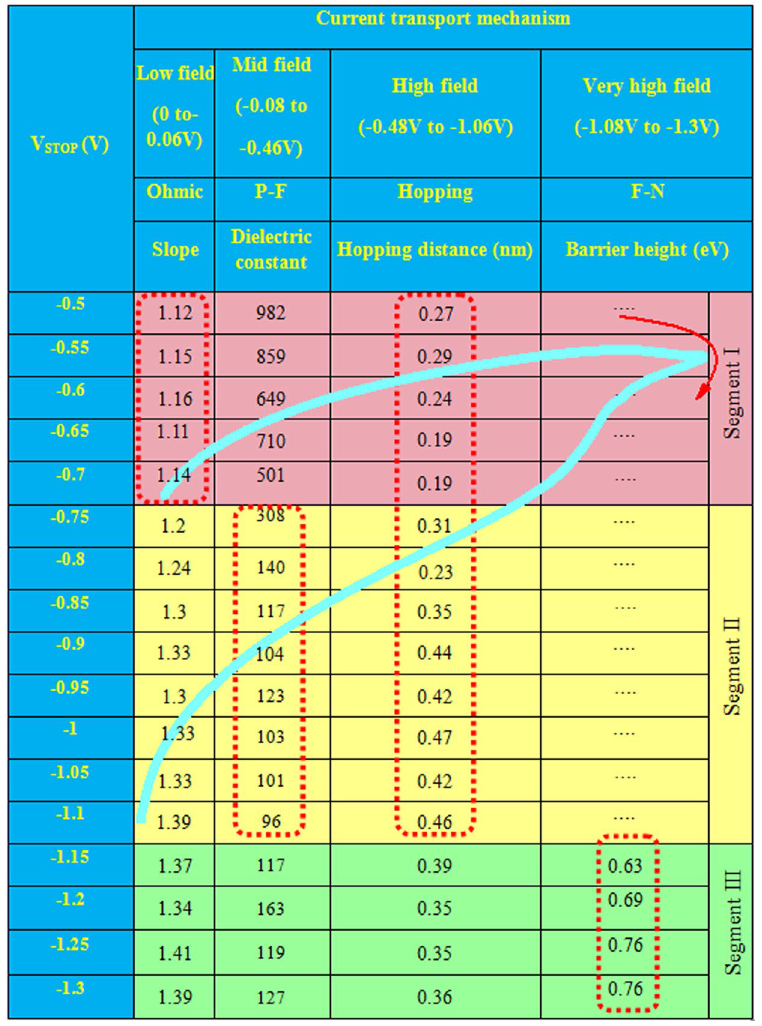
Figure 9. Parameter obtained from current transport characteristics under RESET. Typical I-V curve changing negative voltage of the S2 devices with a size of 0.4 × 0.4 µ m 2